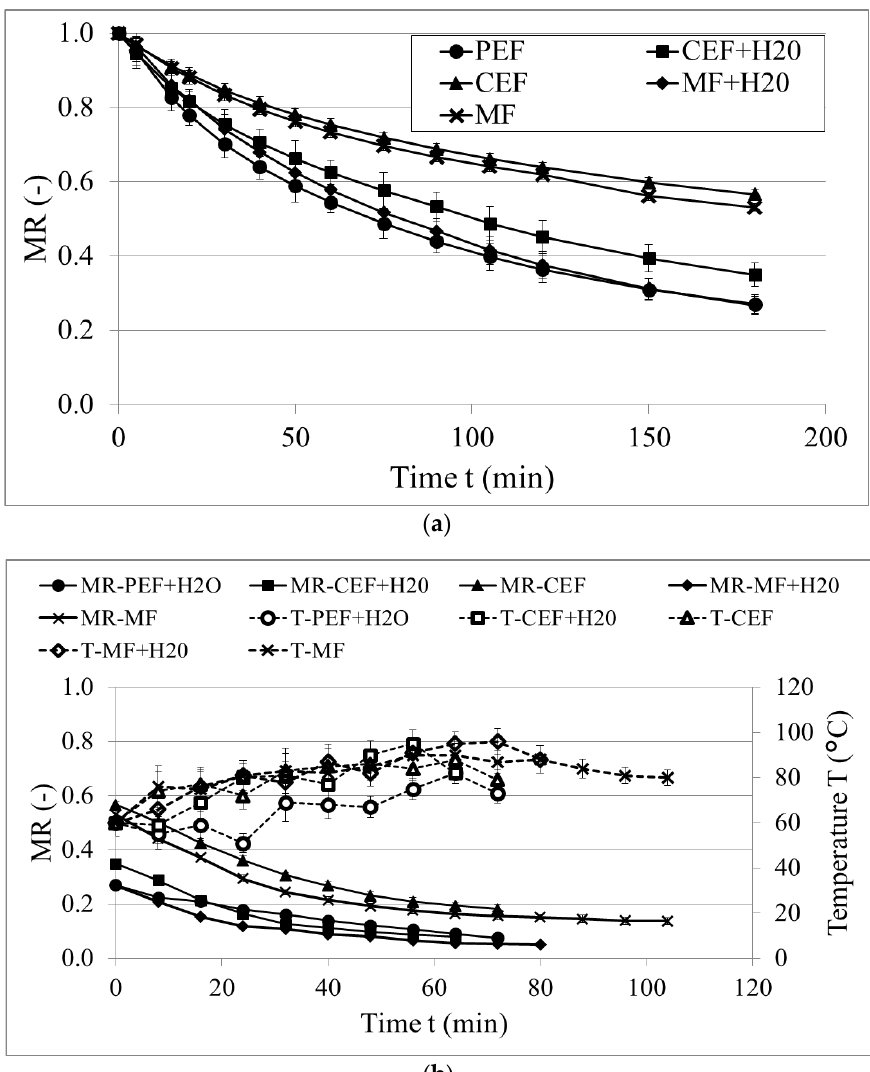
Figure 3. Drying kinetics of pretreated black garlic using a pulsed electric field (PEF), a constant electric field (CEF) and a magnetic field (MF) followed by drying using convective pre-drying ( a ) and vacuum-microwave finishing drying ( b ).